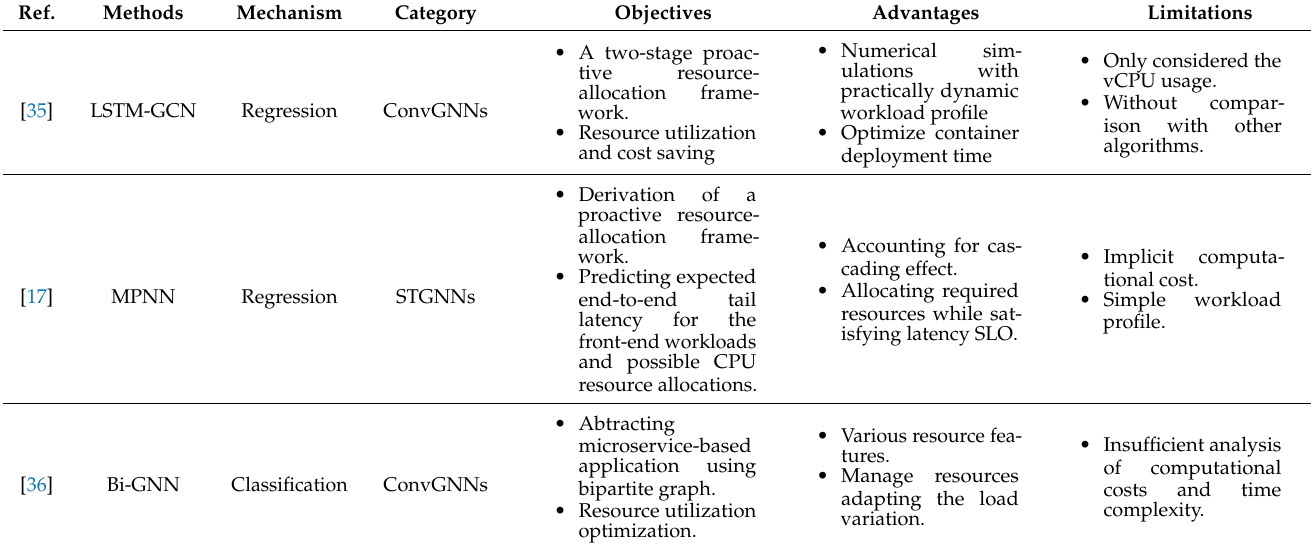
Table 6. Summary of scheduling